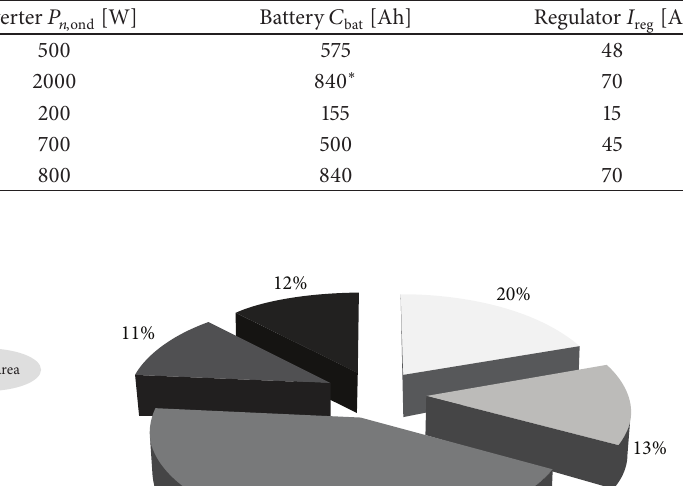
Table 3: Characteristics of the PV system components.